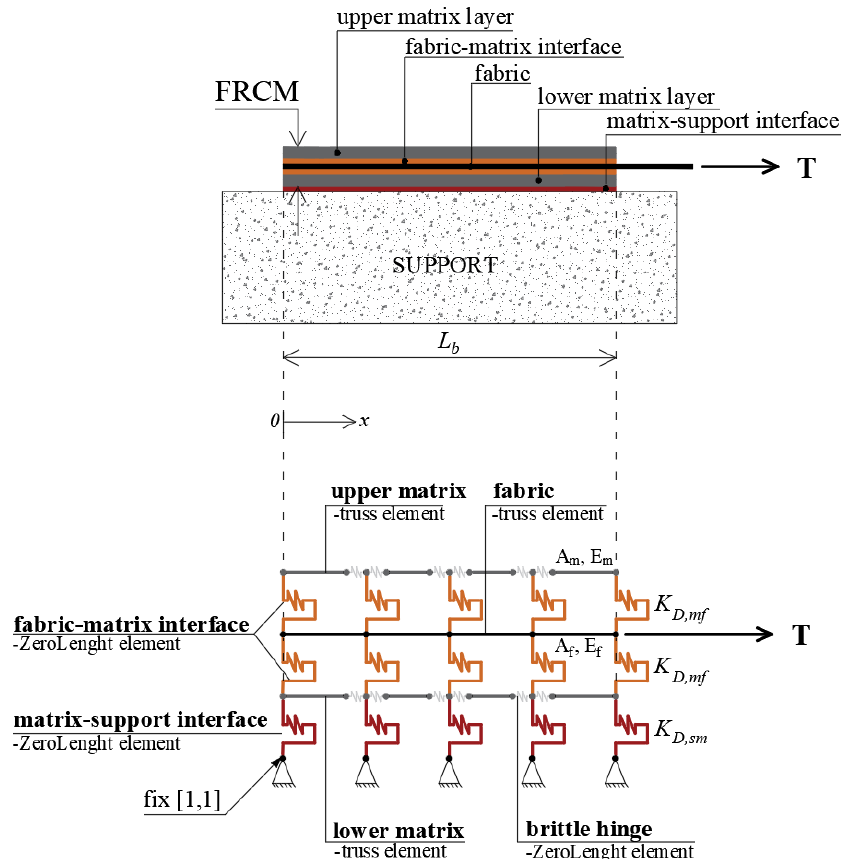
Figure 5. 1D numerical models for shear bond